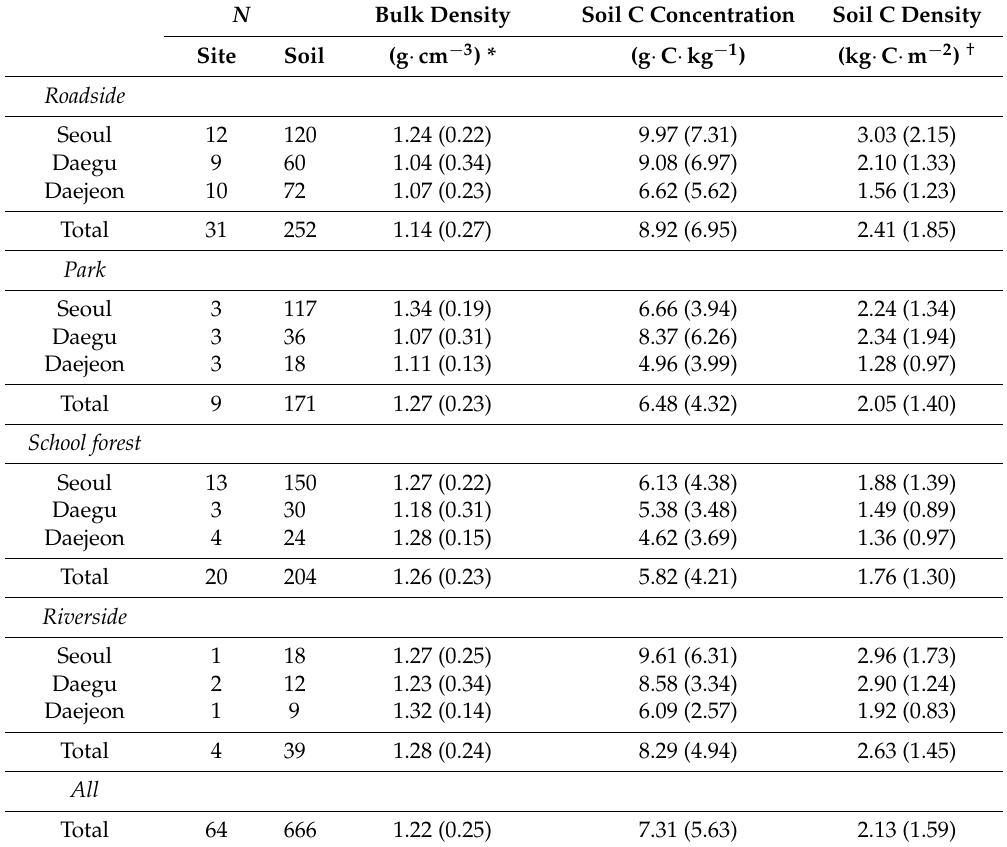
Table 2. Soil bulk density, C concentration, and area-based C density in urban green spaces (UGS) soils for 0–30 cm depth. Values in parentheses represent one standard